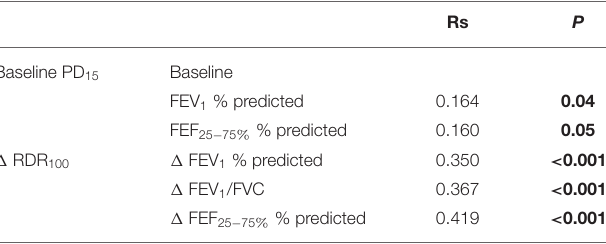
TABLE 5 | Spearman’s correlation between change in spirometry and change in RDR 100 from baseline to follow-up ICS treatment visit and between baseline PD 15 and baseline spirometry variables.